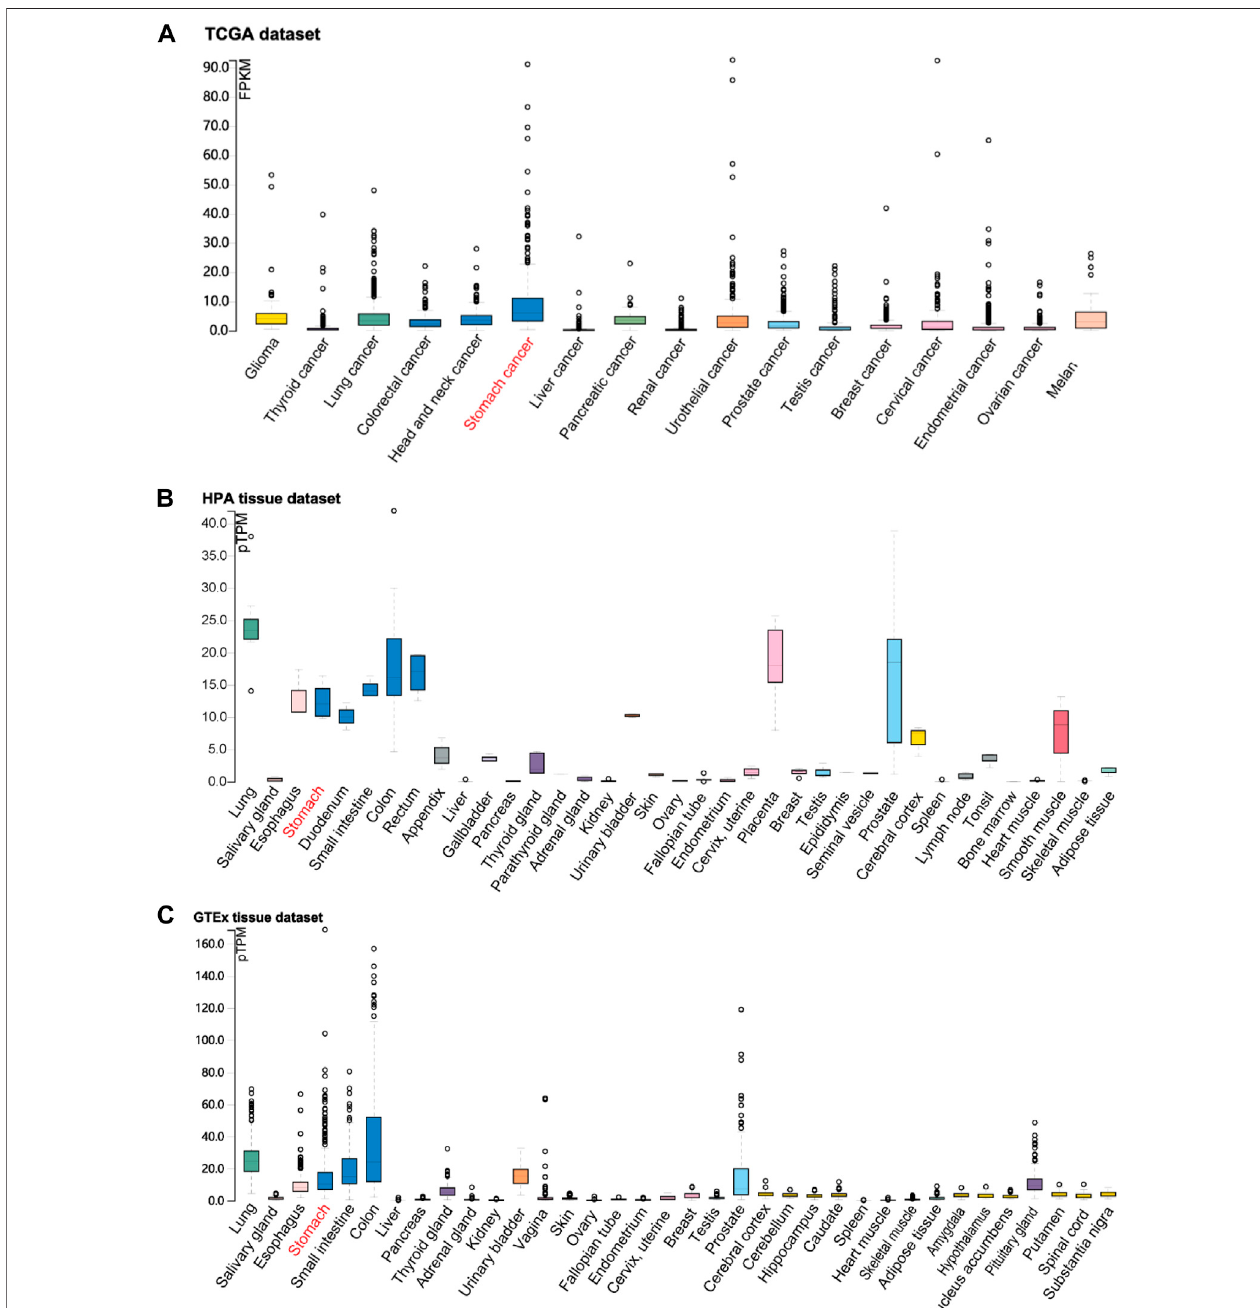
FIGURE2| ThevisualizationofFOXF2expressioninhumantissues.FOXF2expression levelinhumancancertissuesand normaltissues fromTCGA (A) ,HPA (B) , and GTEx (C) datasets.